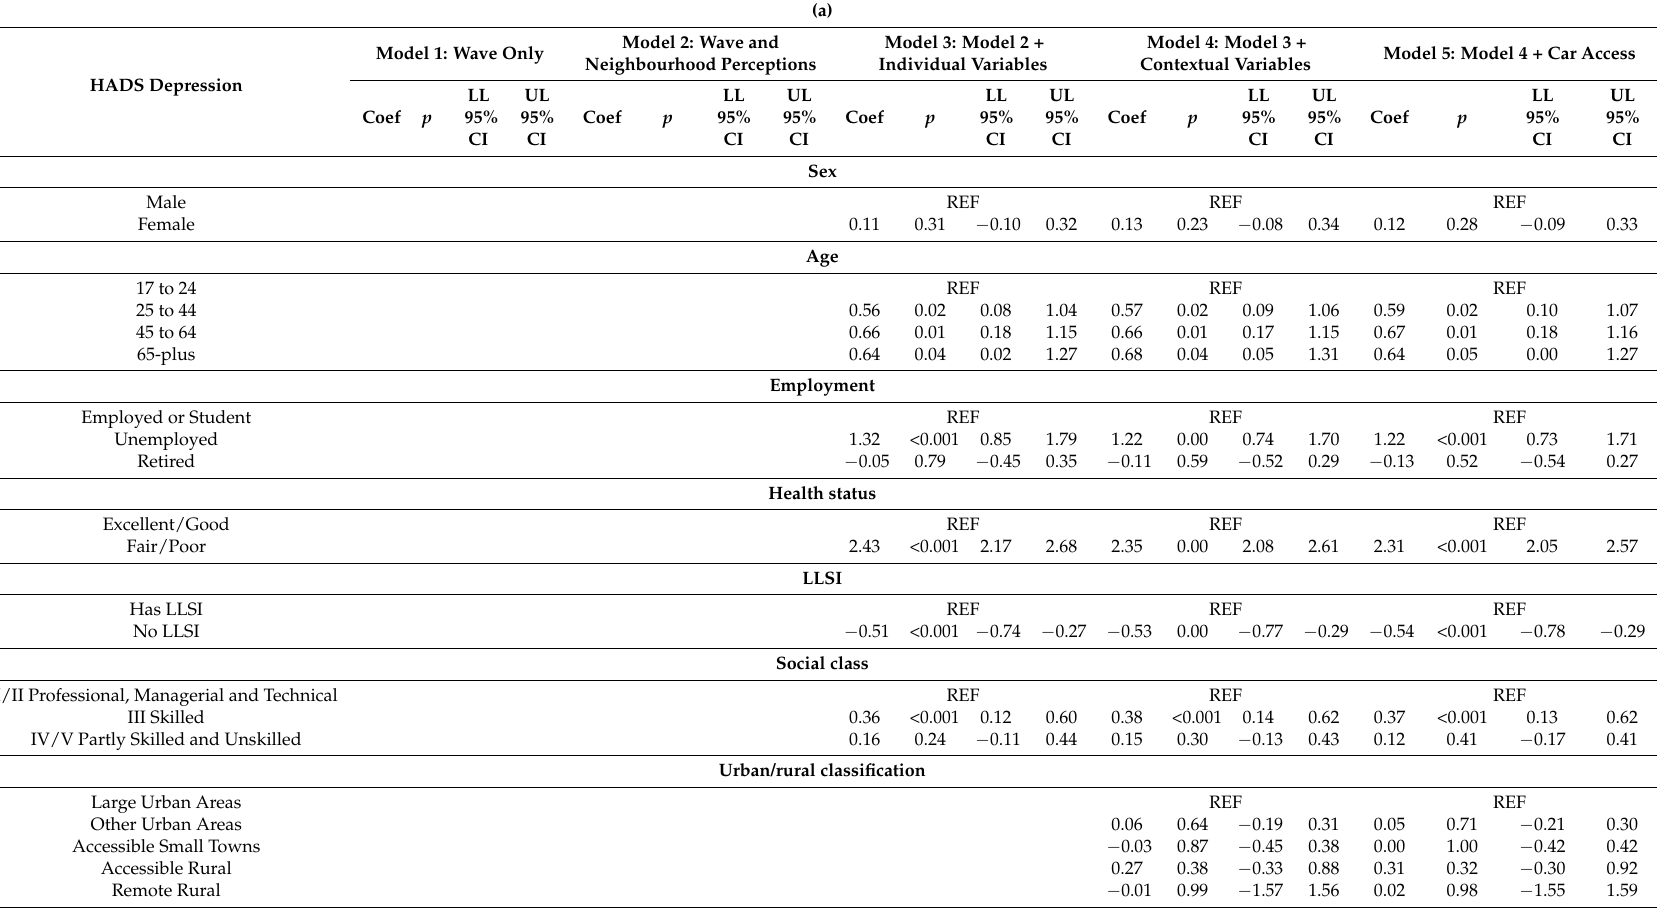
Table 2. ( a ) Multilevel linear regression analyses of HADS depression, wave, individual level variables, contextual level variables and neighbourhood perceptions. ( b ) Multilevel linear regression analyses of HADS anxiety, wave, individual level variables, contextual level variables and neighbourhood